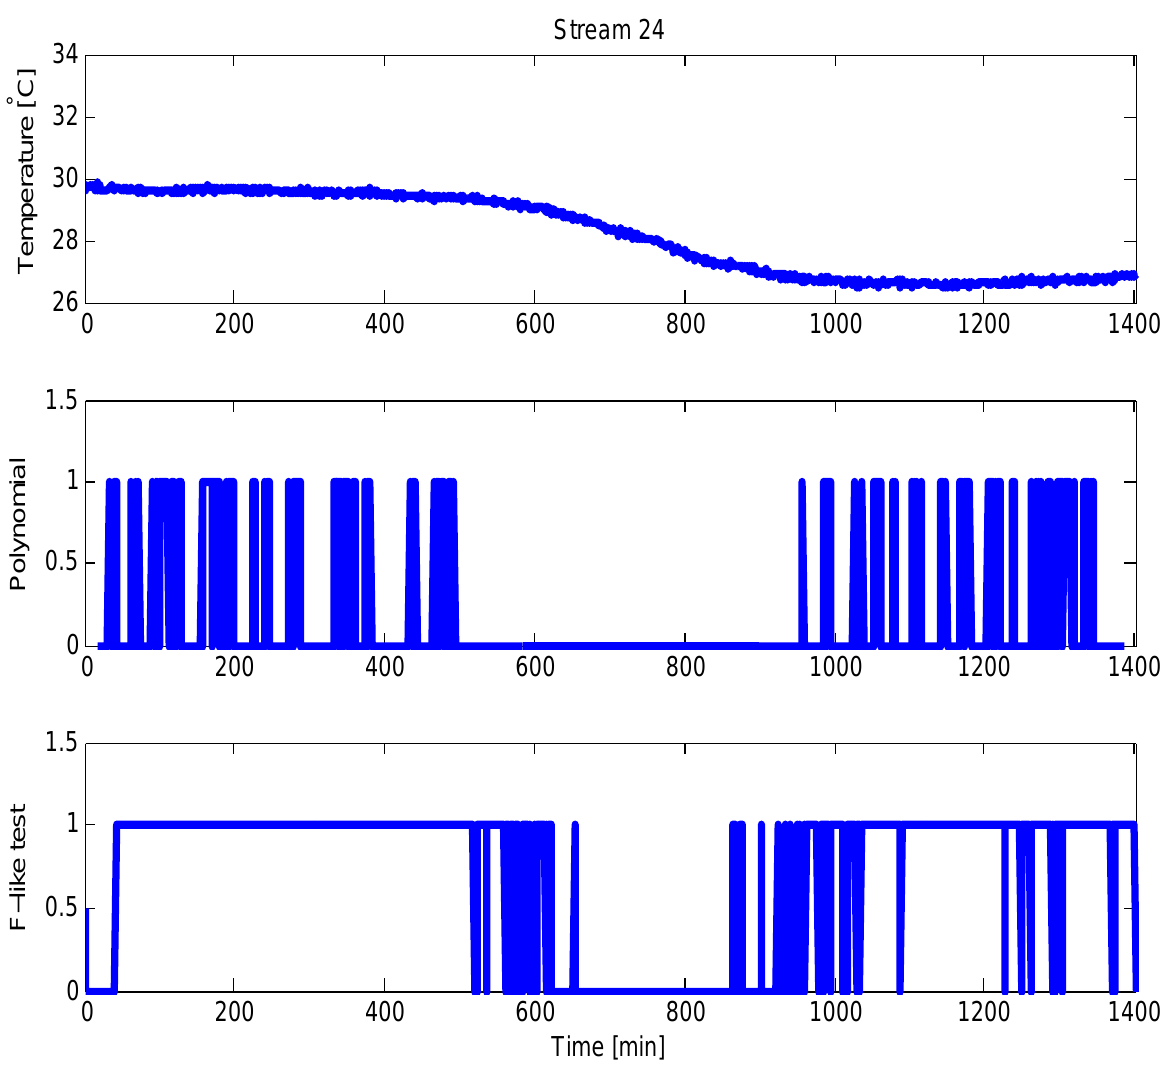
Figure 13. Depropanizer reflux drum case temperature experimental data, in